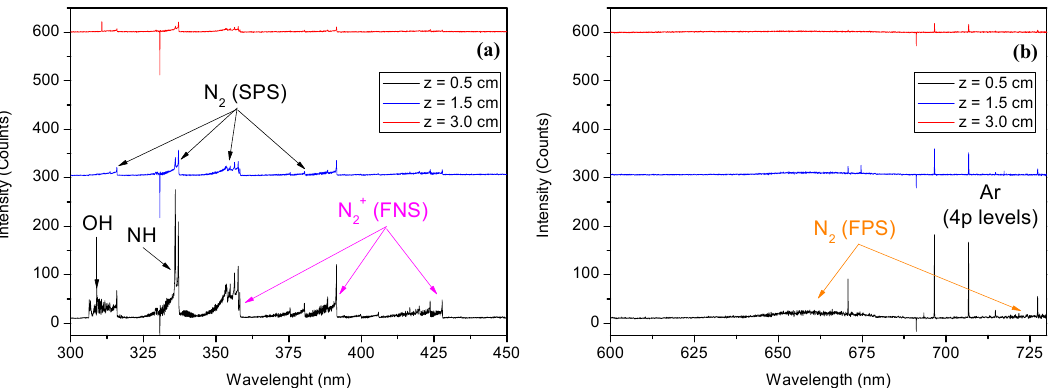
Figure 5. Optical emission spectra of the postdischarge at different axial positions away from the end of the discharge in the ( a ) 300–450 nm and ( b ) 600–730 nm spectral ranges. The Second Positive System (SPS), whose signal is due to the existence of N 2 (C (cid:2871) Π (cid:2931) ) excited molecules could either be generated by Penning excitation (1) with Ar metastable atoms or by nitrogen metastable pooling (10). Both formation channels are possible since the existence of both Ar metastable atoms and nitrogen N 2 A 3 Σ + metastable molecules in the postdischarge region is demonstrated by the emission of Ar lines and the FPS, respectively.